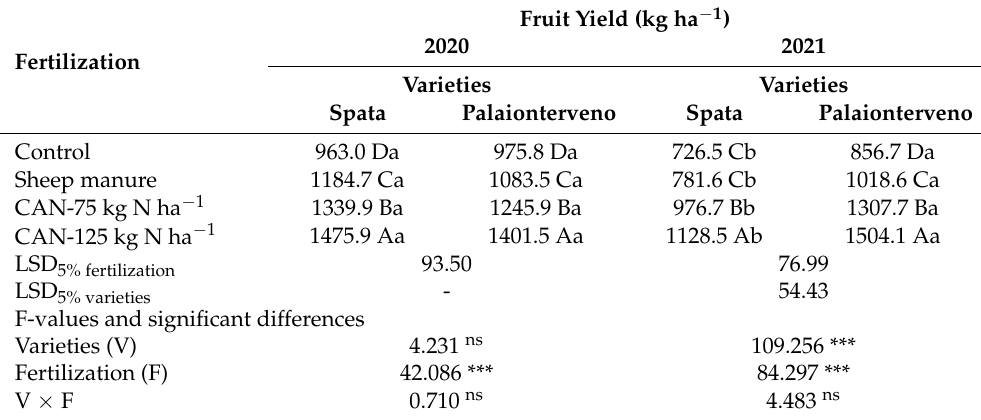
Table 5. Effects of two milk thistle varieties (Palaionterveno and Spata) and fertilization regimes (sheep manure and inorganic fertilizer) on fruit yield of milk thistle crop. Fruit Yield (kg ha − 1 Fertilization